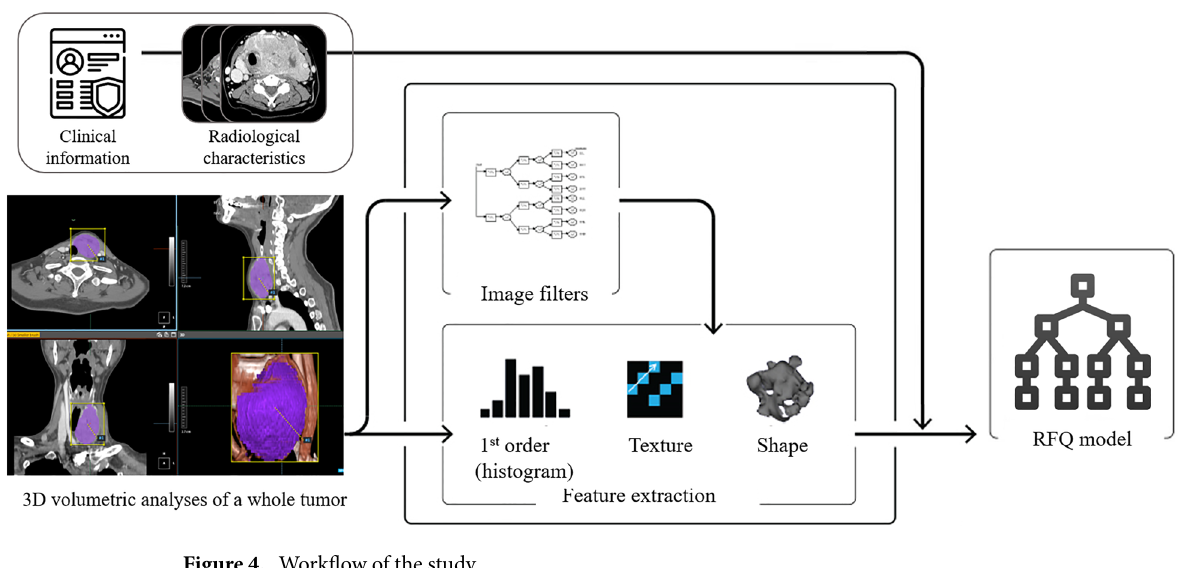
Figure 4. Workflow of the